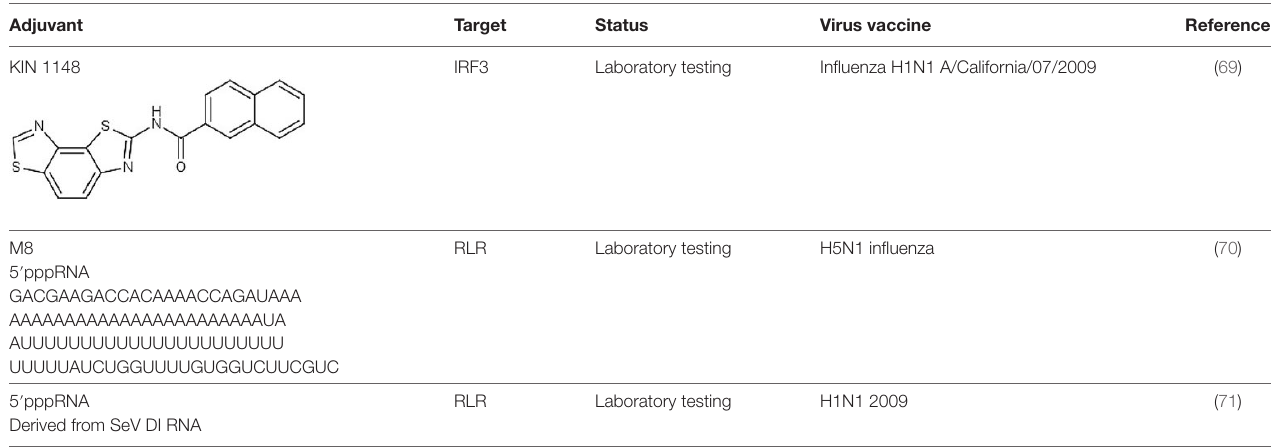
TABLe 2 | Innate immune potentiator as virus vaccine adjuvants. Adjuvant